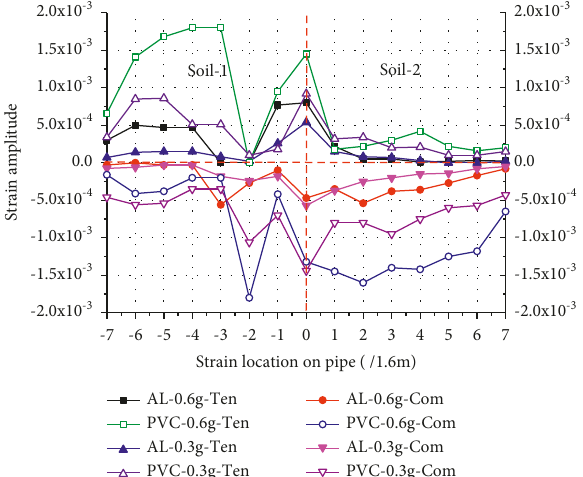
Figure 15: Strain amplitudes of pipelines by seismic